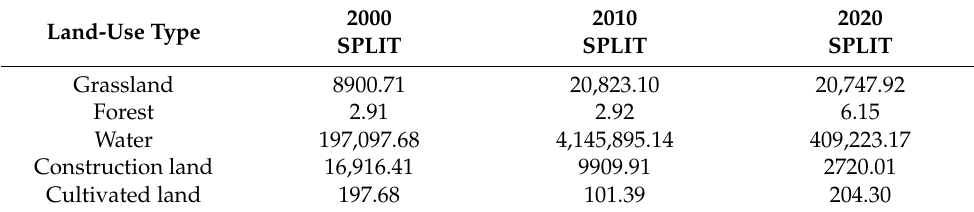
Table 8. The index of landscape fragmentation from 2000 to